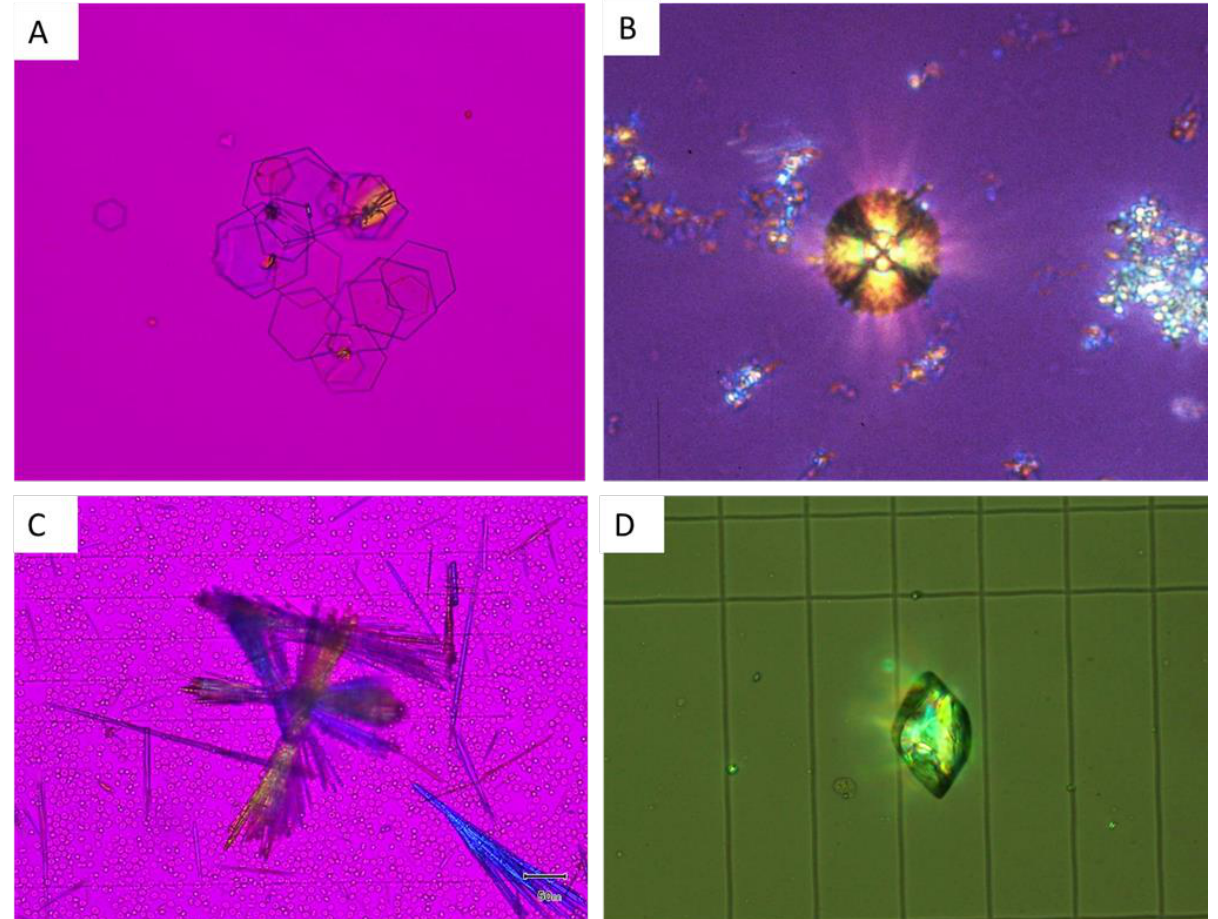
Figure 7. Crystalluria: “genetic” and drug-induced urine crystals. ( A ) Cystine crystals, with a typical hexagonal aspect. ( B ) 2,8 dihydroxyadenine crystals, with the typical “maltese cross” aspect in polarized light. ( C ) amoxicillin crystals in the urine of a patient affected by acute kidney injury. ( D ) sulfamethoxazole crystals in the urine of a patient affected by acute kidney